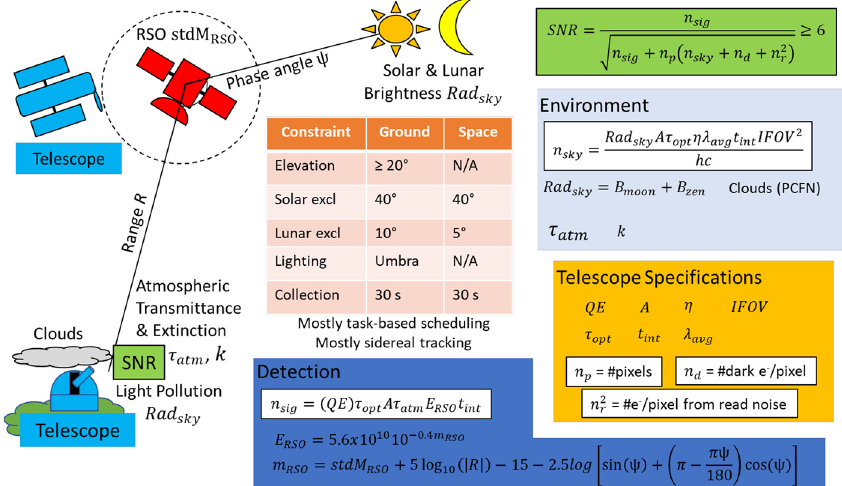
Figure 1. Optical collection chain (the red RSO is collected by the blue telescopes only if SNR constraints, determined by supporting parameters, are ful fi